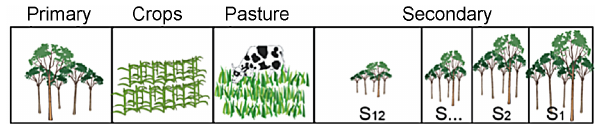
Figure 10. In the GFDL ESM2M and ESM2G CMIP5 simulations each grid cell has up to 15 land tiles, including lakes, glaciers, croplands, pasturelands, primary, and up to 10 secondary vegeta- tion tiles. All GFDL models use gross transitions from the LULCC scenarios. The secondary vegetation tiles are generated by wood harvesting (primary to secondary and secondary to secondary tran- sitions) as well as by agricultural abandonment (croplands to sec- ondary and pastures to secondary transitions). Each land-use tile has its own C anthropogenic pool and separate above- and below- ground C stores. For LUMIP, all variables on primary and secondary tiles will be aggregated and reported under the PSL tile. Urban is not represented and will be reported as missing values. Glaciers and lakes are not